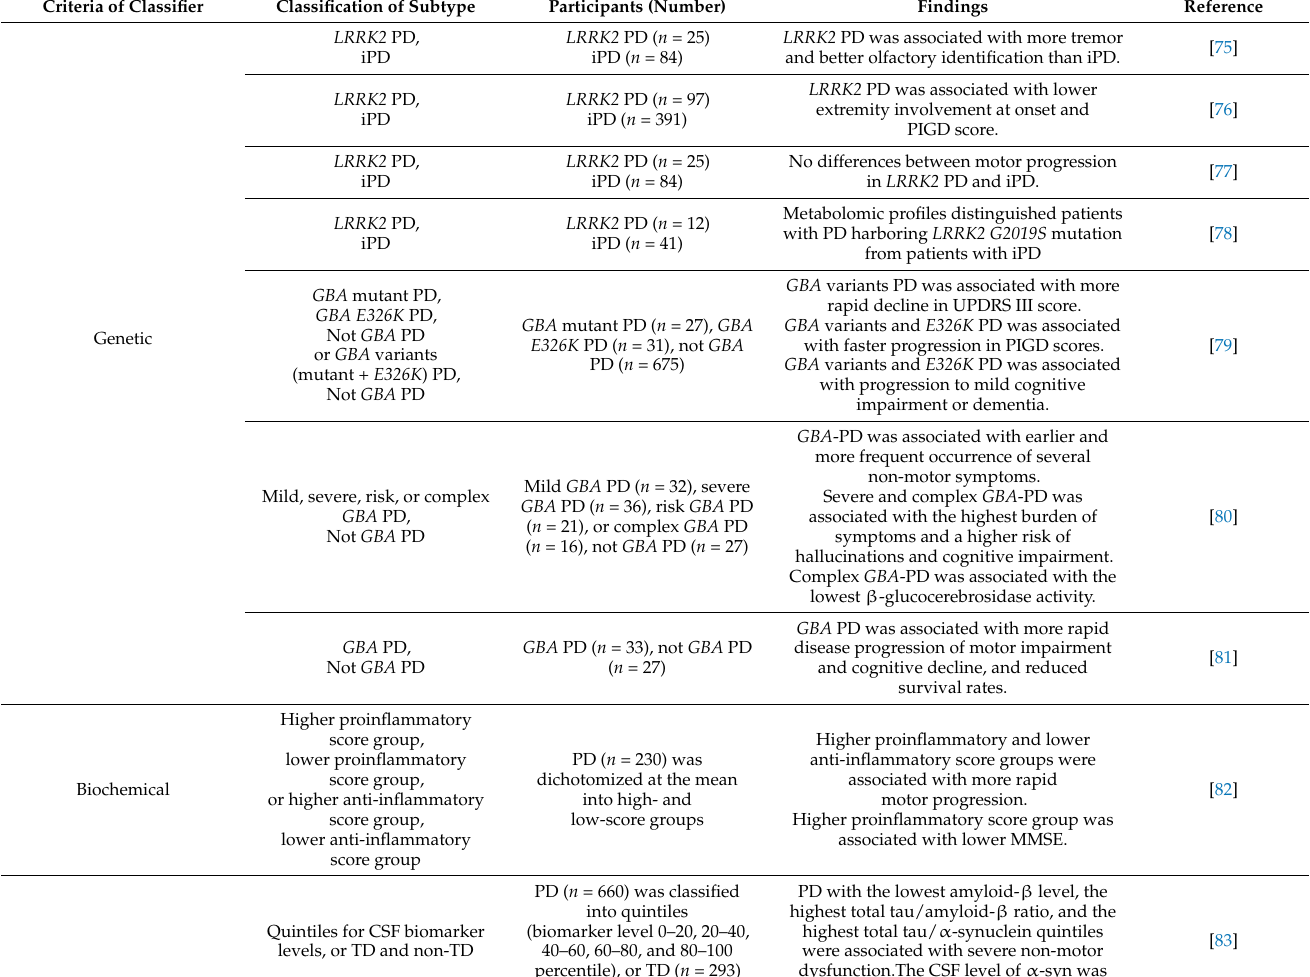
Table 3. Molecular